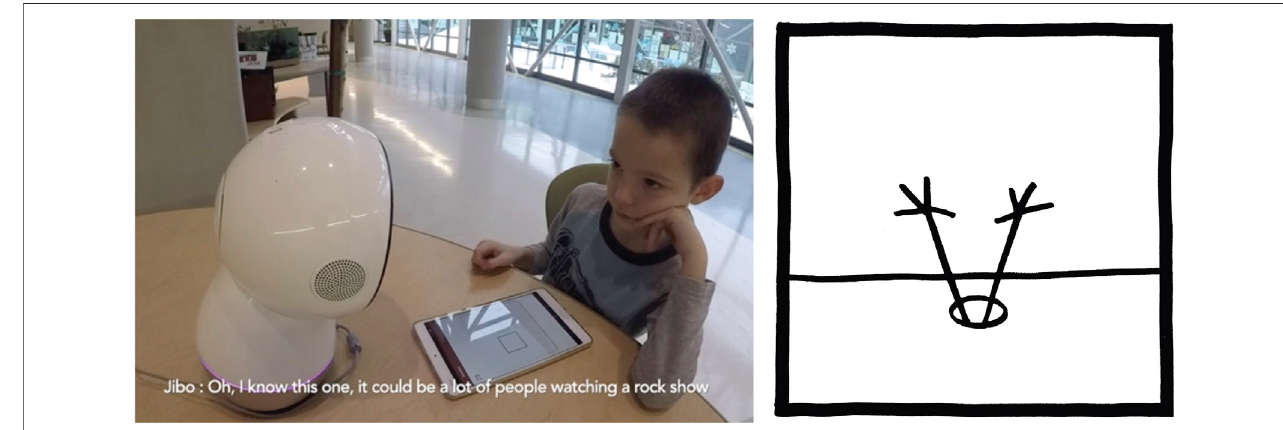
FIGURE 1 | Interaction Scene. (A) A child is playing the Droodle Creativity Game on an Android Tablet with social robot Jibo. (B) Example of a Droodle Image. 10 Droodles were used in the Droodle Creativity Game ( fi ve per player).